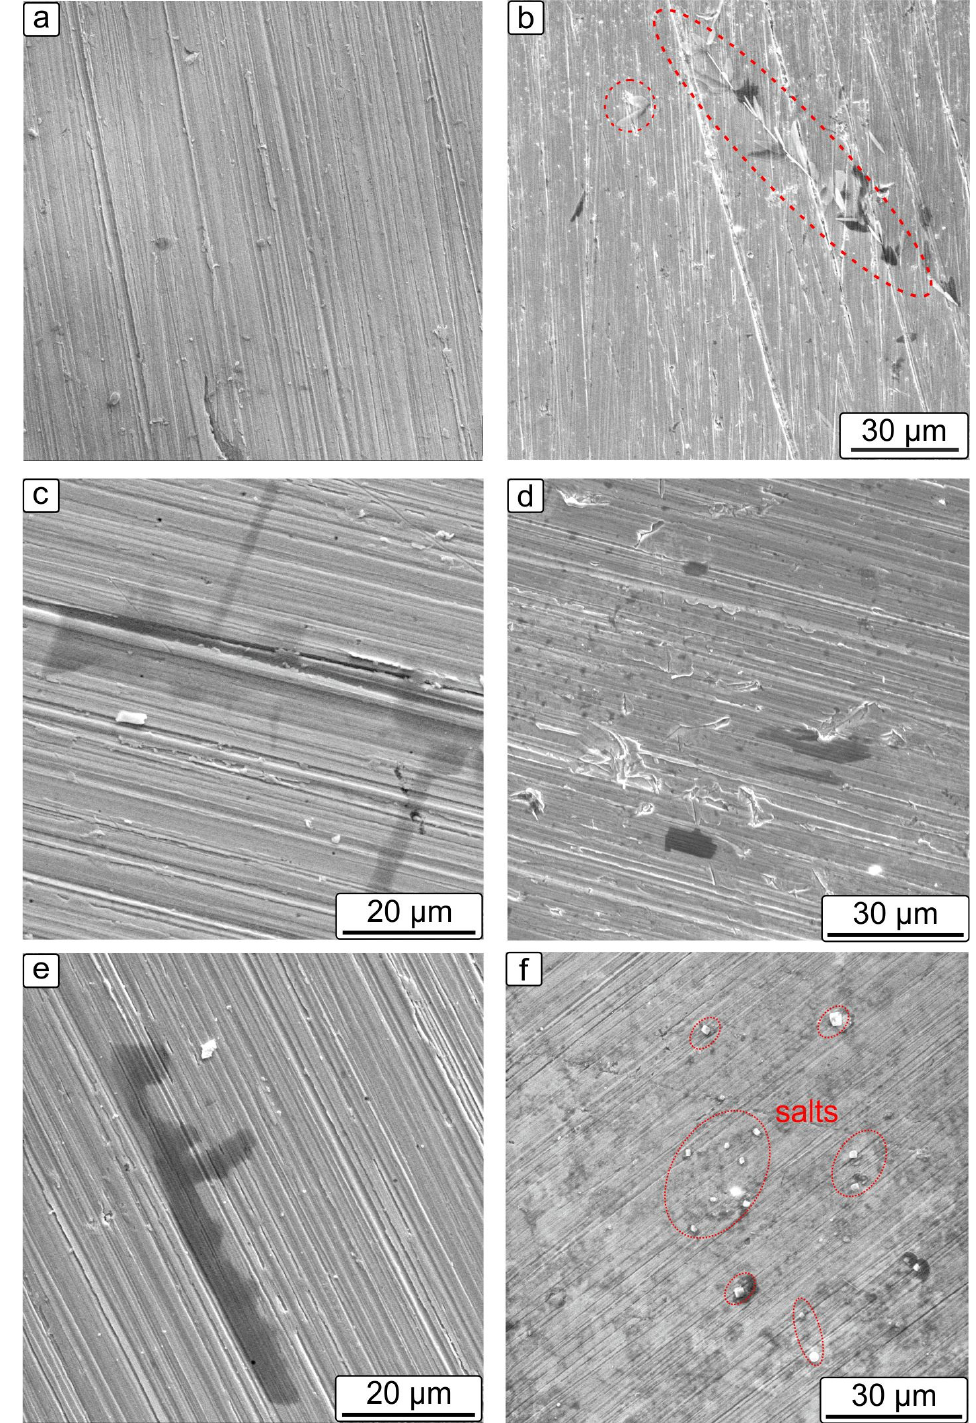
Figure 8. SEM images for SS 316L ( a , c , e ) and SS 304L ( b , d , f ) after potentiodynamic corrosion testing in unloaded MEA solution.